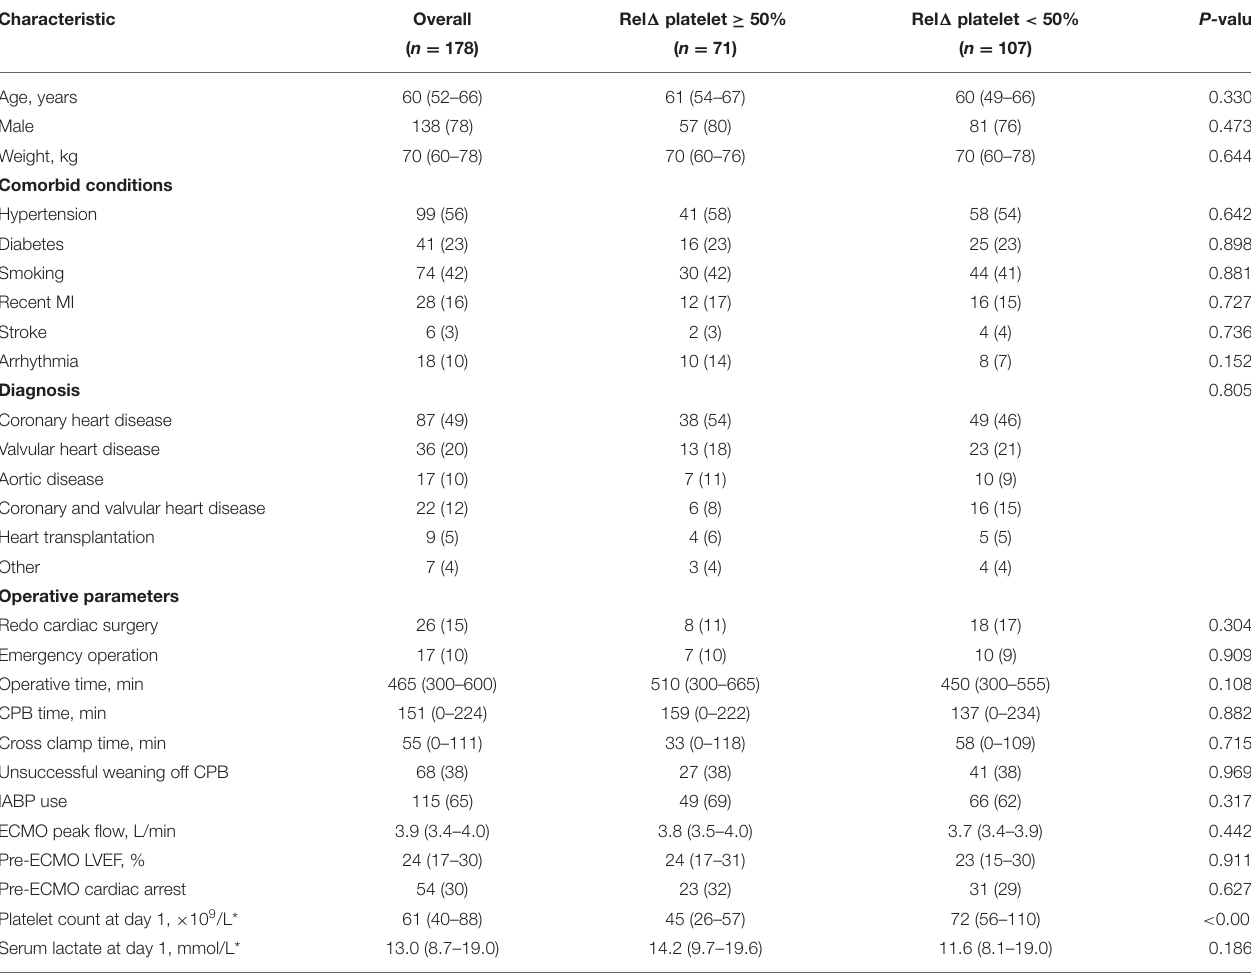
TABLE 1 | Clinical characteristics of the